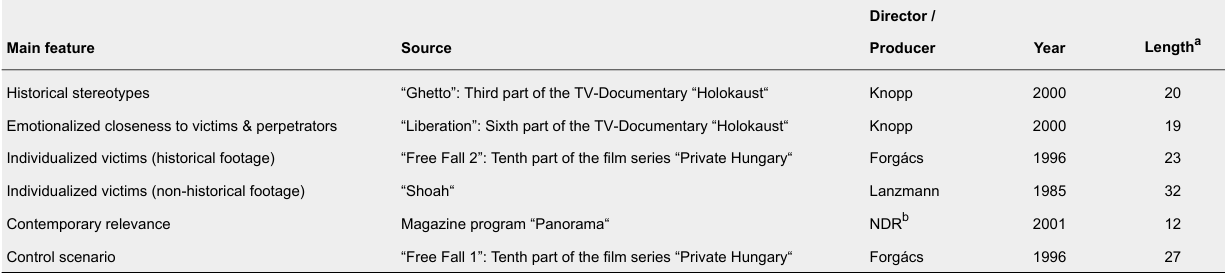
Sources of Stimulus